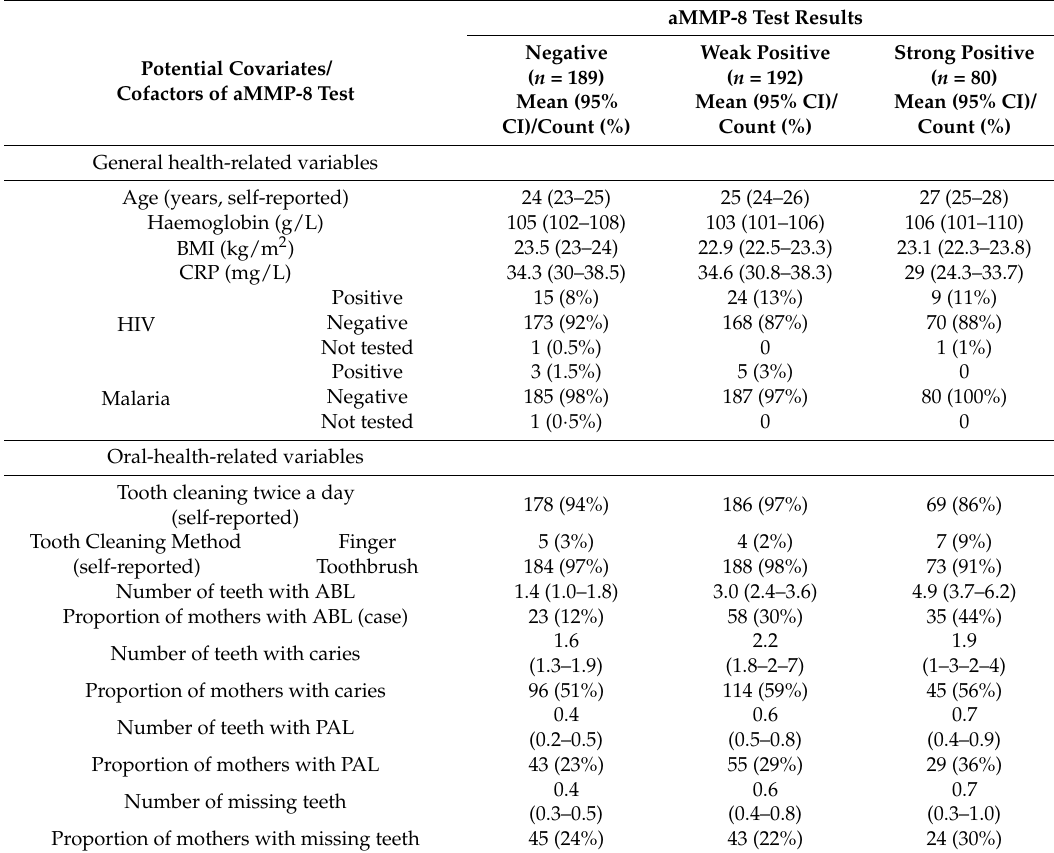
Table 2. Potential covariates of aMMP-8 test results and alveolar bone loss.